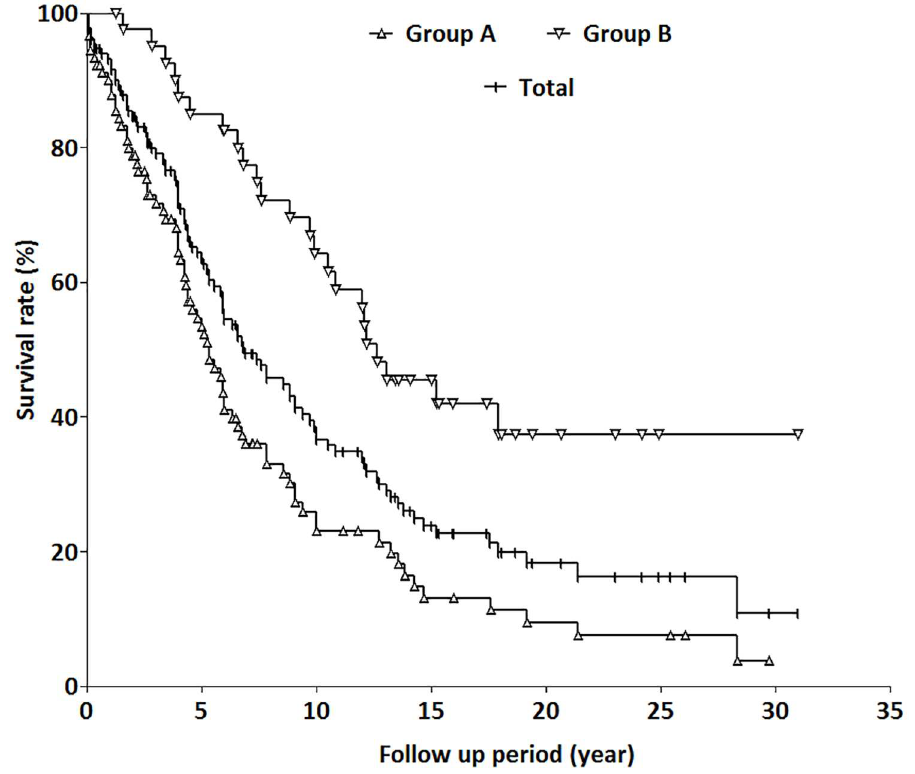
Fig 2. Thyroid cancer-specific survival rates for the three groups of patients with bone metastasis. The disease-specific survival rates for groups A, B, and for all patients includedin the study were 53.4%, 85.0%, and 63.5% at 5 years; 22.9%, 64.2%, and 36.7% at 10 years; 9.4%, 37.3%, and 18.2% at 20 years; and 3.7%, 37.3%, and 10.8% at 30 years, respectively.The difference in disease-specific mortality rates betweengroups A and B was significantdifference ( p <